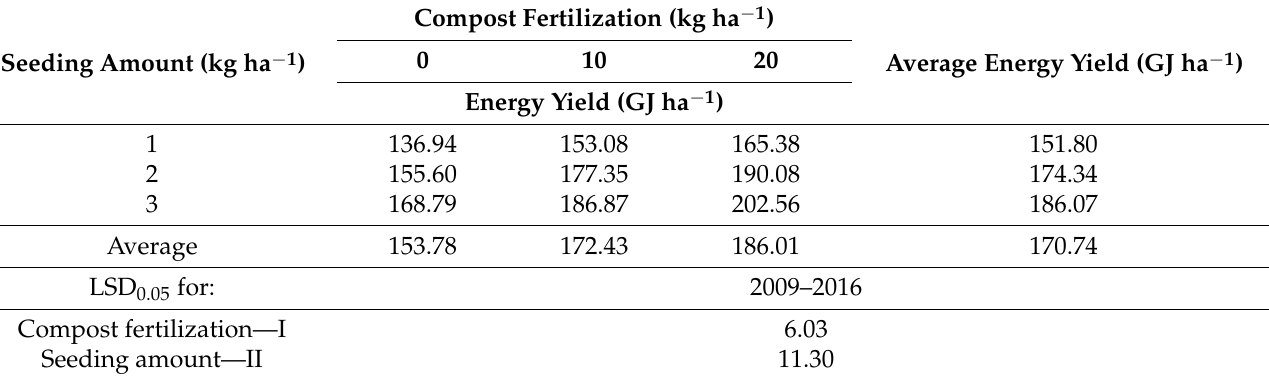
Table 8. Effects of seeding amount and fertilization with compost on the average energy yield (GJ ha − 1 ) of Sida during the years of full use